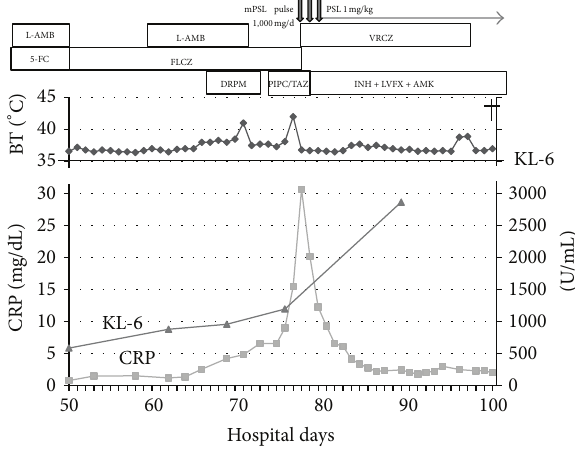
Table 2: Major test results of CSF, blood, and sputum.